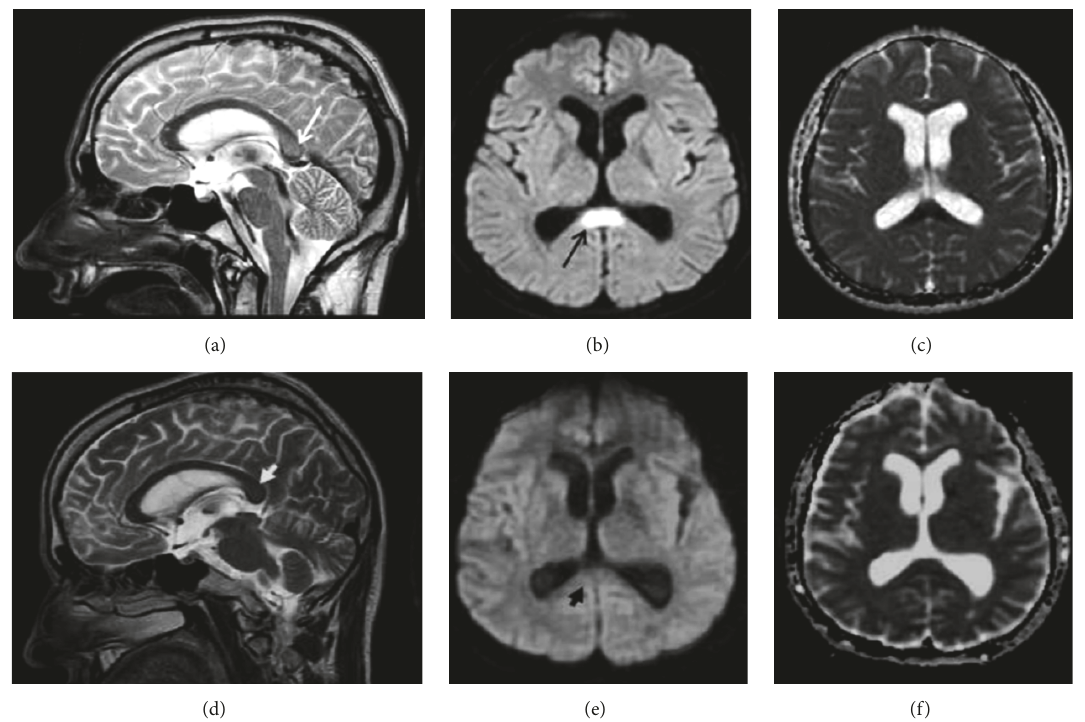
Figure 1: MRI studies at onset (a-c) and 1-month follow-up (d-f). Sagittal FSE-T2 image (a) demonstrating hyperintense regions in the splenium of the corpus callosum ( white arrow ). DWI (b) image shows its hyperintense signal ( black arrow ) and ADC map (c) shows its reduced diffusivity. Corresponding sagittal FSE-T2 image (d) and DWI images (e) showing normal signal in the splenium of the corpus callosum ( white arrow head and black arrow head , respectively) where the ADC map (f) shows normalization of water